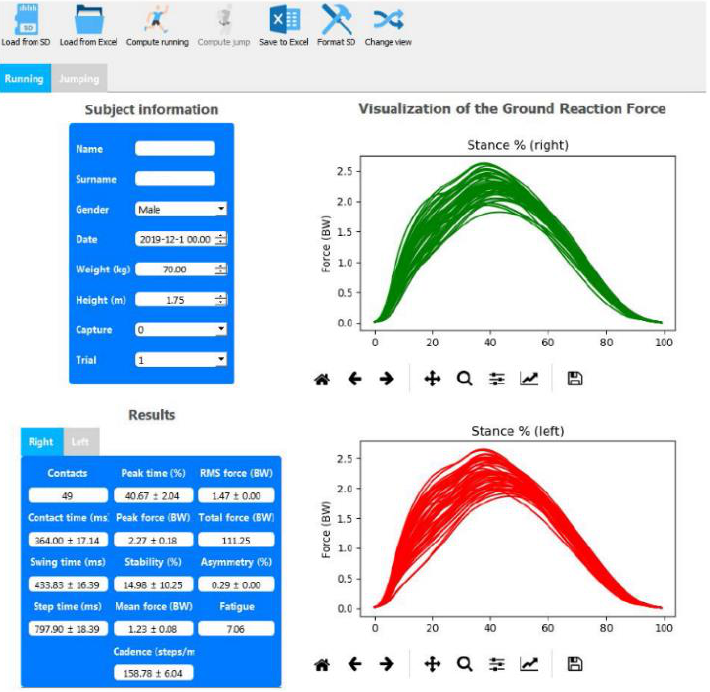
Figure 12. View of a processed running trial showing GRF curves for each stride and running metrics for both legs.